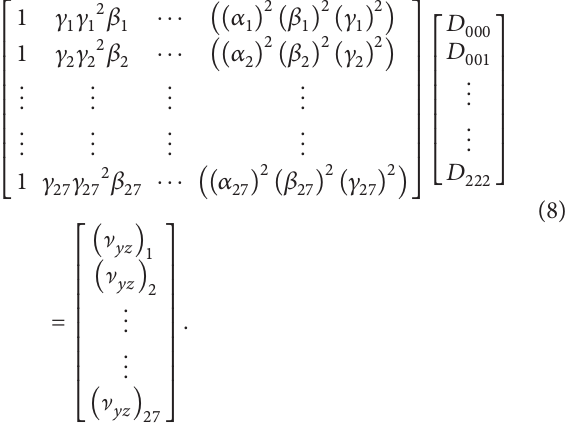
Table 1: Values of 𝛼 , 𝛽 , and 𝛾 used in analysed models. Model